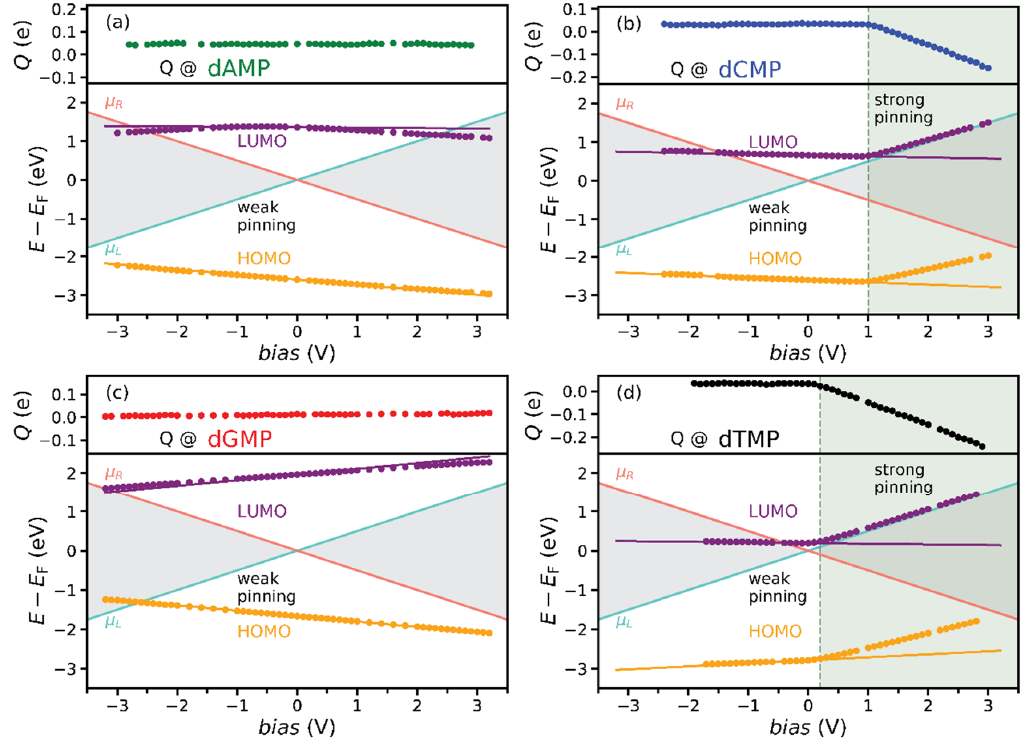
Figure 3. Pinning regimes diagram showing the bias dependence MPHS HOMO (orange dots) and LUMO (purple dots) energies with respect to Fermi energy E F of ( a ) dAMP, ( b ) dCMP, ( c ) dGMP, and ( d ) dTMP and Hirshfeld charge excess Q (black dots) accumulated on the molecules (in the upper part). Solid orange and purple lines are the weak-pinning HOMO and LUMO energy estimate E WP HOMO/LUMO ( bias ) = E P ( bias , < z HOMO/LUMO >) − E P (0, < z HOMO/LUMO >) + E HOMO/LUMO (0) − E F from the empty gap (Figure 2b). The green-shaded region marks the strong pinning bias domain, which starts at a bias value indicated with the green dotted line. The electrochemical potentials µ L and µ R of the left and the right electrode are given as light blue and red lines, and the bias window between them is the gray-shaded